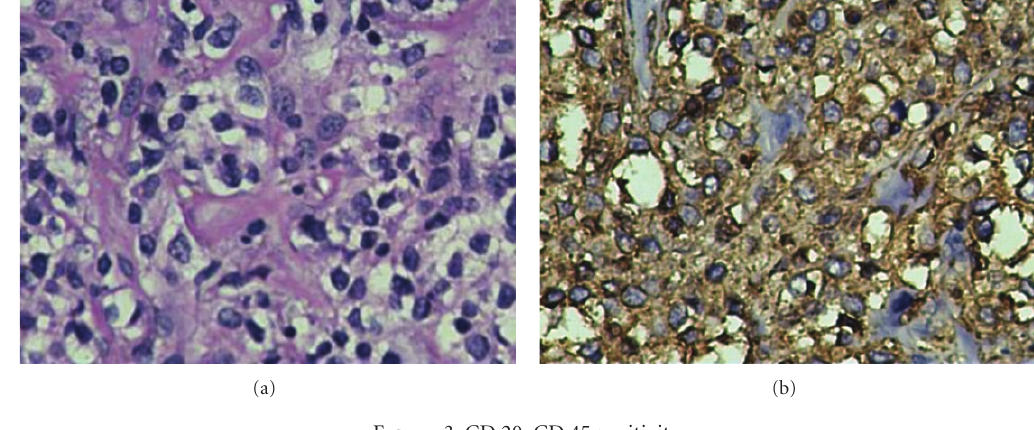
Figure 3: CD 20, CD 45 positivity.